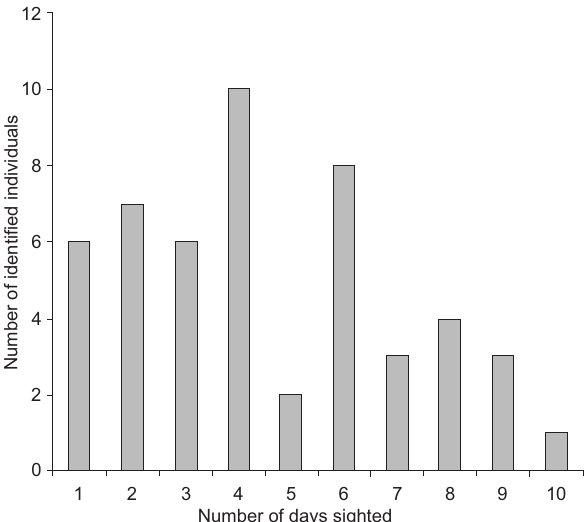
marks.Figure 2. Sighting frequencies of bottlenose dolphins presenting conspicuous long-lasting marks on the dorsal